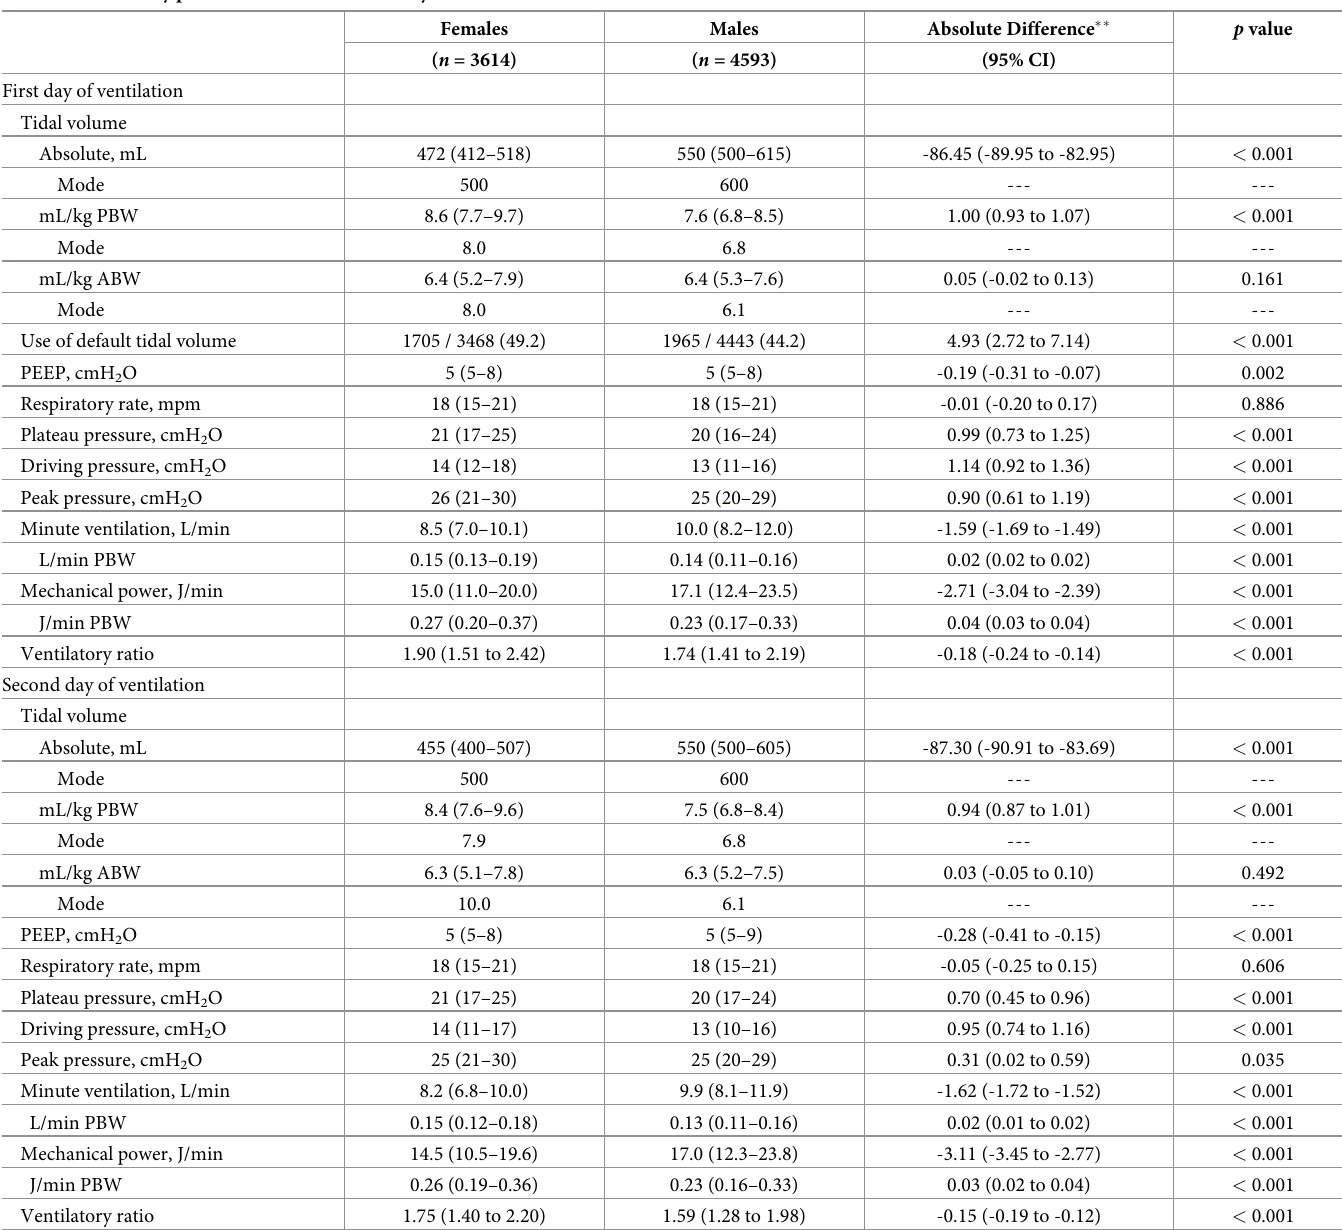
Table 1. Ventilatory parameters in the first two days of ventilation �